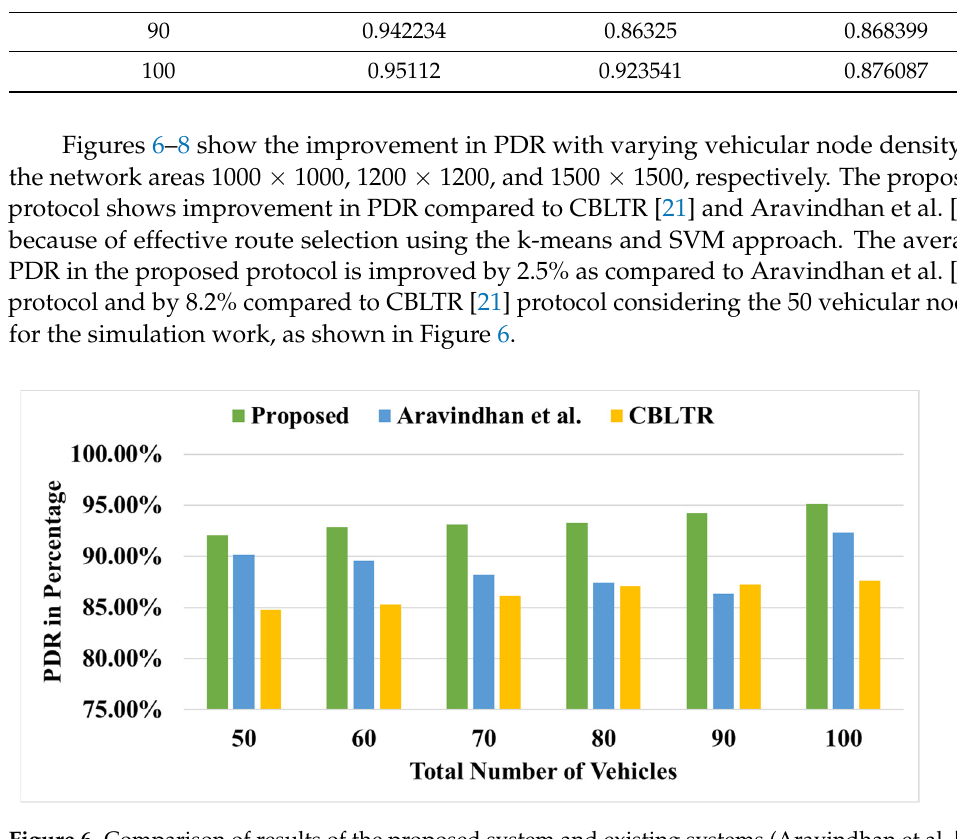
Figure 6. Comparison of results of the proposed system and existing systems (Aravindhan et al. [24] and CBLTR [21]) on PDR versus vehicular nodes in area 1000 × 1000.